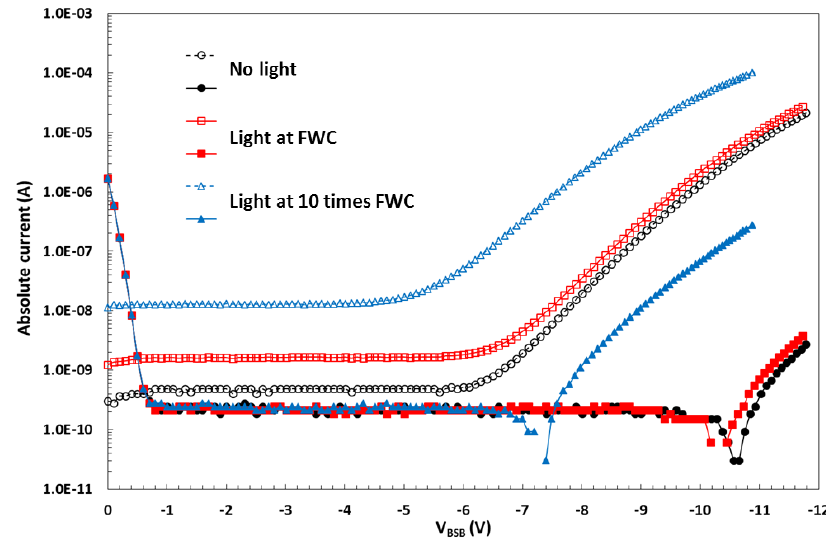
Figure 11. Whole chip (open symbols) and array substrate (closed symbols) currents in a 10 µm pixel design variant #3 with high V pin and medium DDE.